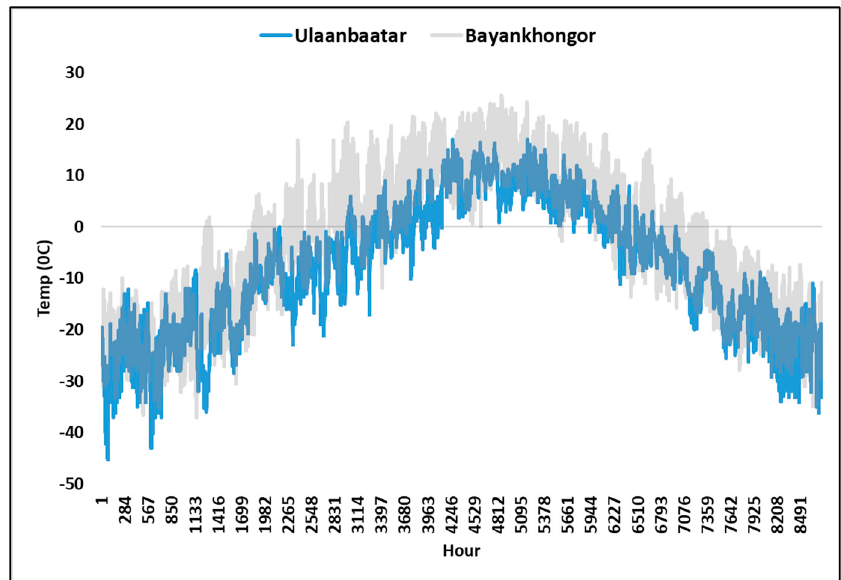
Figure 11. Hourly ambient temperature in UB and Bayankhongor. Table 9. Comparison of the e xpected co-benefits from the combined scenario in UB and Bayank- hongor (Estimated by the authors).